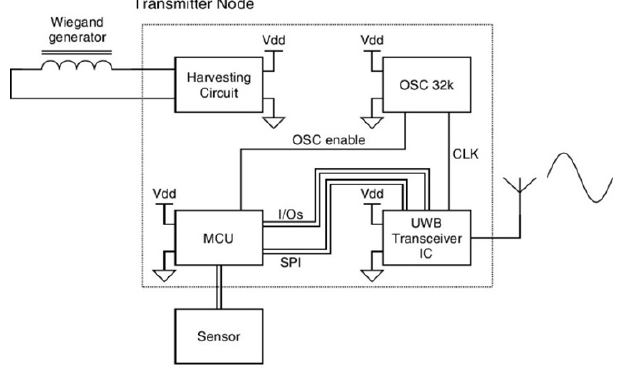
Figure 1. Wiegand sensor for energy-self-sufficient motion sensing (top) and Wiegand generator (right).